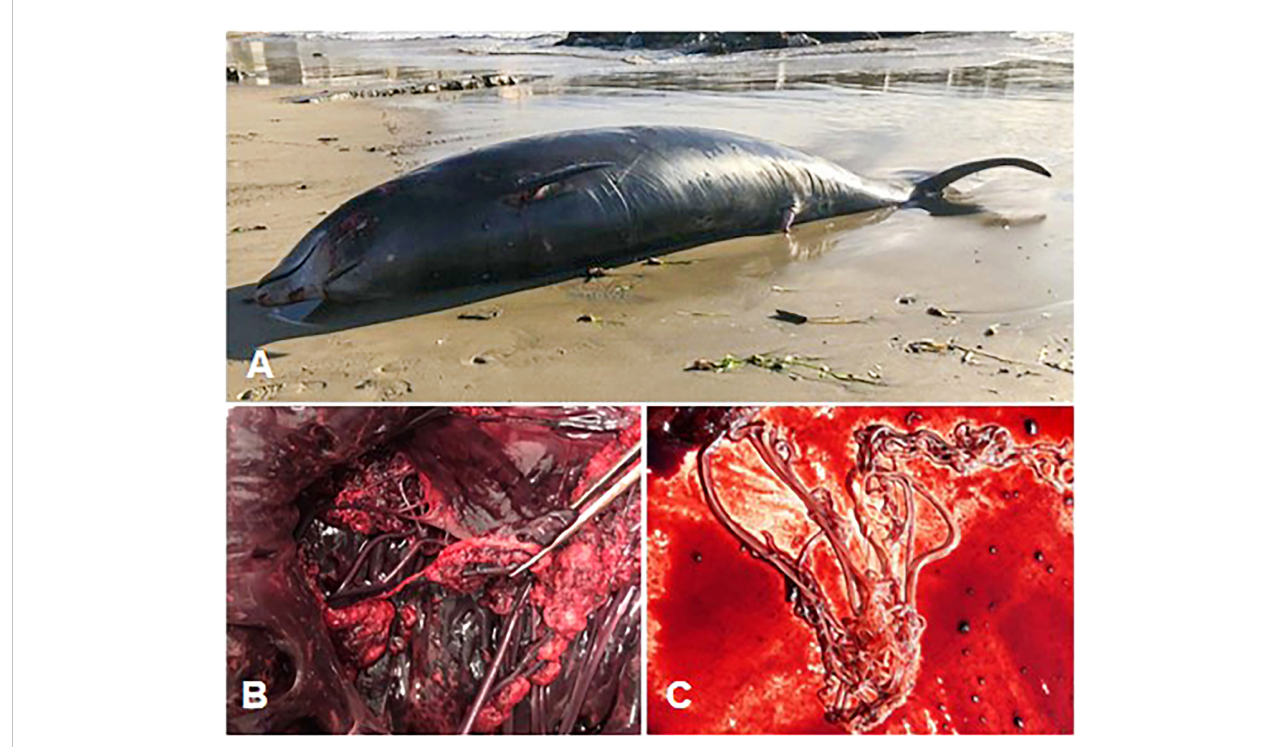
FIGURE 1 (A) Cuvier ’ s beaked whale carcass before retrieval. (B) Right atrioventricular valve - fi brinous valvular endocarditis. (C) Adult Crassicauda spp. nematodes retrieved from the renal parenchyma for parasitological